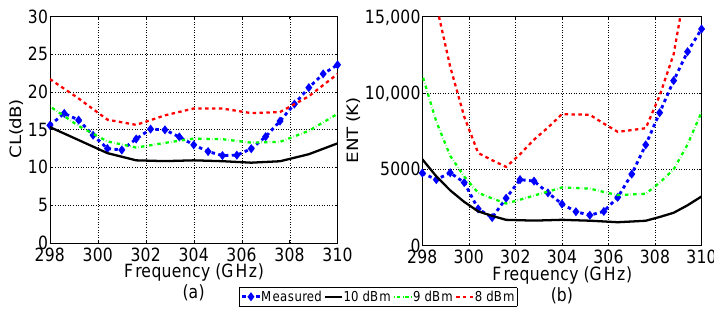
Figure 9. ( a ) Measured conversion loss of the integrated receiver subharmonic mixer and comparison with predicted performance. ( b ) Measured equivalent noise temperature of the integrated receiver subharmonic mixer and comparison with predicted performance.